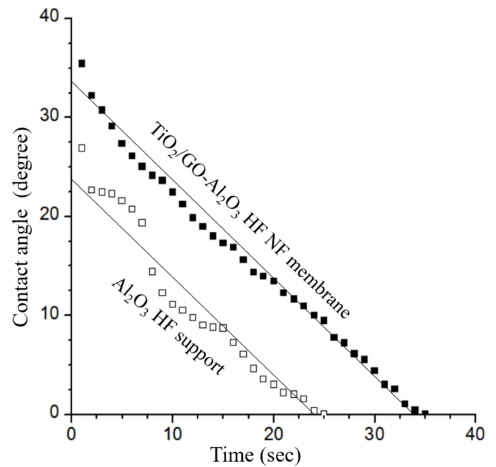
Figure 7. Water contact angle ( ◦ ) versus time of the Al 2 O 3 HF support and TiO 2 /GO-Al 2 O 3 HF NF membrane.